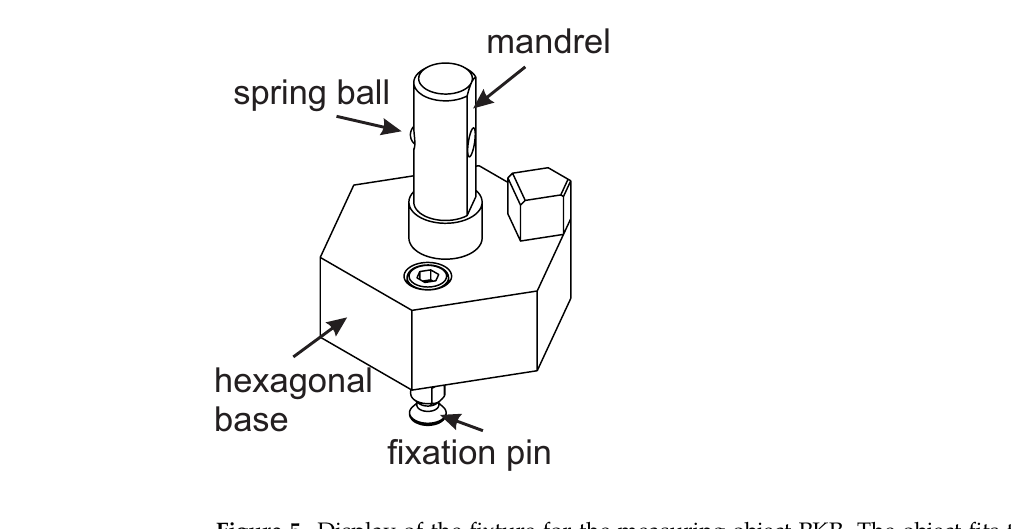
Figure 5. Display of the fixture for the measuring object PKR. The object fits the fixture with its internal diameter, and the spring ball provides additional stability. The fixture is pneumatically mounted in the working area of the Equator via a pin in the pneumatic cylinder.